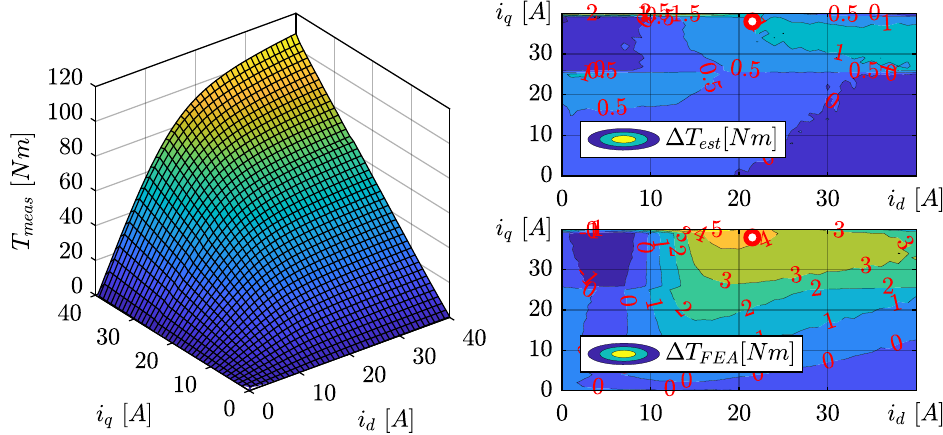
Figure 11. Measured torque map ( left ) and torque difference contours ( right ) for the